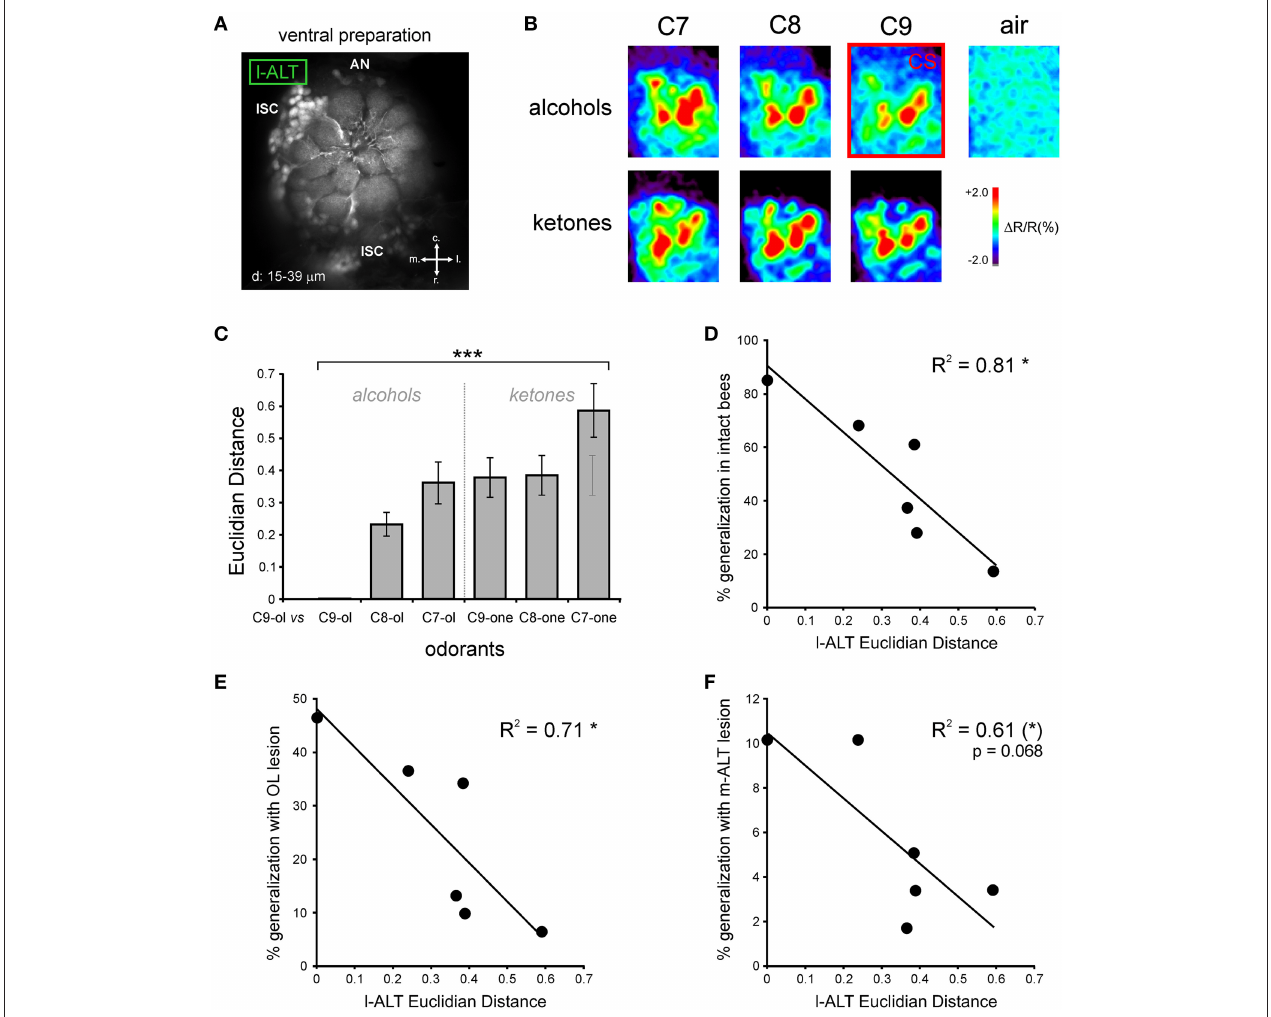
FIGURE 7 | Comparison of neural coding in l-ALT neurons with behavioral performances. (A) Retrograde staining of l-ALT PNs innervating ventral AL glomeruli (adapted from Carcaud et al., 2015). Z-projection of optical slices performed at the indicated depths (d). Abbreviations: r, rostral; c, caudal; l, lateral; m, medial; lSC, l-ALT PN somata cluster; AN, antennal nerve. (B) Odor-induced calcium signals in l-ALT PNs in the AL to the six different odorants, differing in their functional group (alcohol and ketone) and their carbon chain length (7, 8, and 9 carbons) and to the air control. The CS in the behavioral experiment (1-nonanol; C9-ol) is framed in red. (C) Euclidian distances (dissimilarity measure between activity maps) calculated between the CS (C9-ol) and the five new tested odorants are significantly different ( *** p < 0.001 , repeated measure ANOVA). (D–F) Significant and similar correlations between l-ALT Euclidian distances and the responses in the generalization tests of: (D) intact bees ( R 2 = 0.81 , * p < 0.05 ); (E) bees with an OL lesion ( R 2 = 0.71 , * p < 0.05 ); and (F) bees with m-ALT lesion ( R 2 = 0.61 , (*) p = 0.068